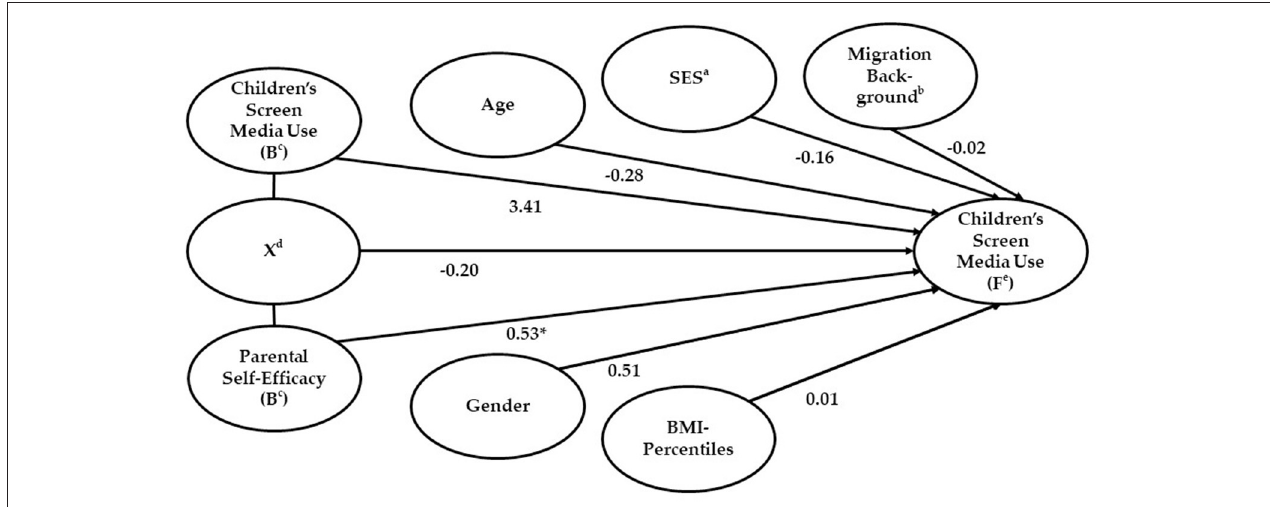
FIGURE 2 | Parental self-efficacy as moderator between the intervention “Join the Healthy Boat” and children’s screen media use. Results of the final model with all predictors (190 cases included; X 2 (8) = 69.57, p < 0.001, model fit: Cox and Snell R X 2 = 0.31, Nagelkerke’s R 2 = 0.41). Statistics are standardized regression coefficients. Lines represent relations. * p < 0.05. a Socio-economic status (parents’ highest educational/occupational qualification, parents’ highest occupational status, and net household income). b Children with at least one parent born in a foreign country or children who were spoken to in a foreign language for the first 3 years or their life. c B, baseline. d X, interaction effect. e F,